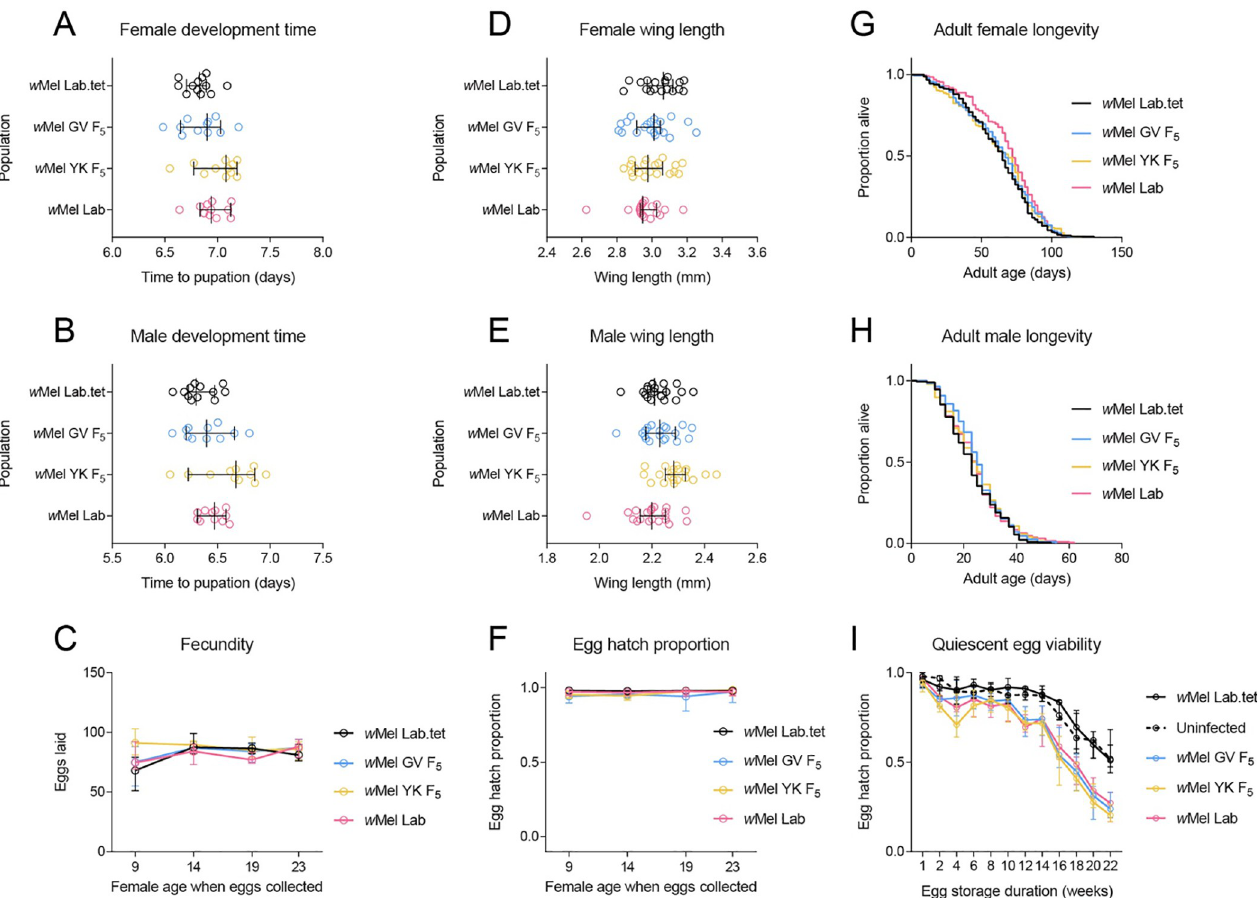
Fig 3. Phenotypic effects of w Mel from lab and field origins in a common Aedes aegypti background. w Mel-infections originating from Gordonvale (GV), Yorkeys Knob (YK) or the laboratory were introduced to a common background through backcrossing. Populations were measured for (A) female and (B) male development time, (C) fecundity, (D) female and (E) male wing length, (F) egg hatch, (G) female and (H) male adult longevity and (I) quiescent egg viability. Dots represent data from replicate trays (A-B) or individual mosquitoes (D-E). Lines and error bars represent medians and 95% confidence intervals in all